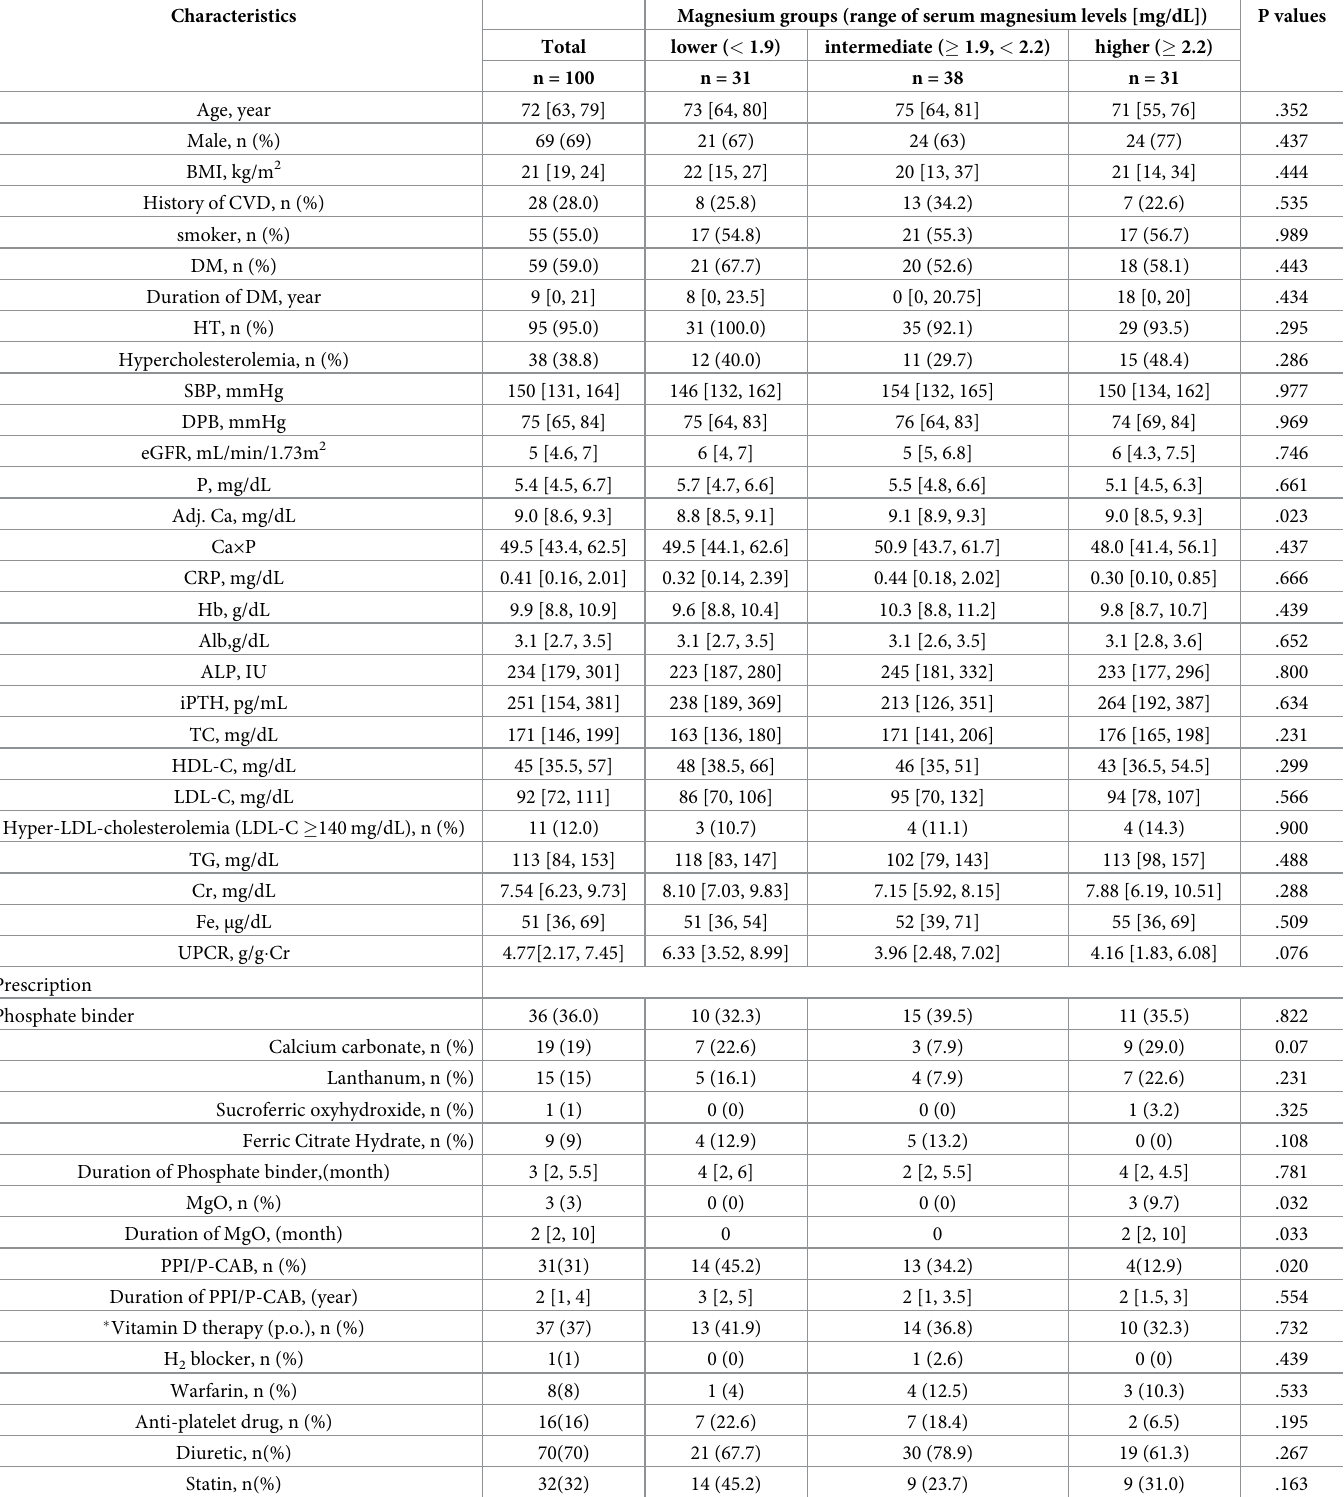
Table 1. Baseline characteristics of patients stratified by Mg categories.